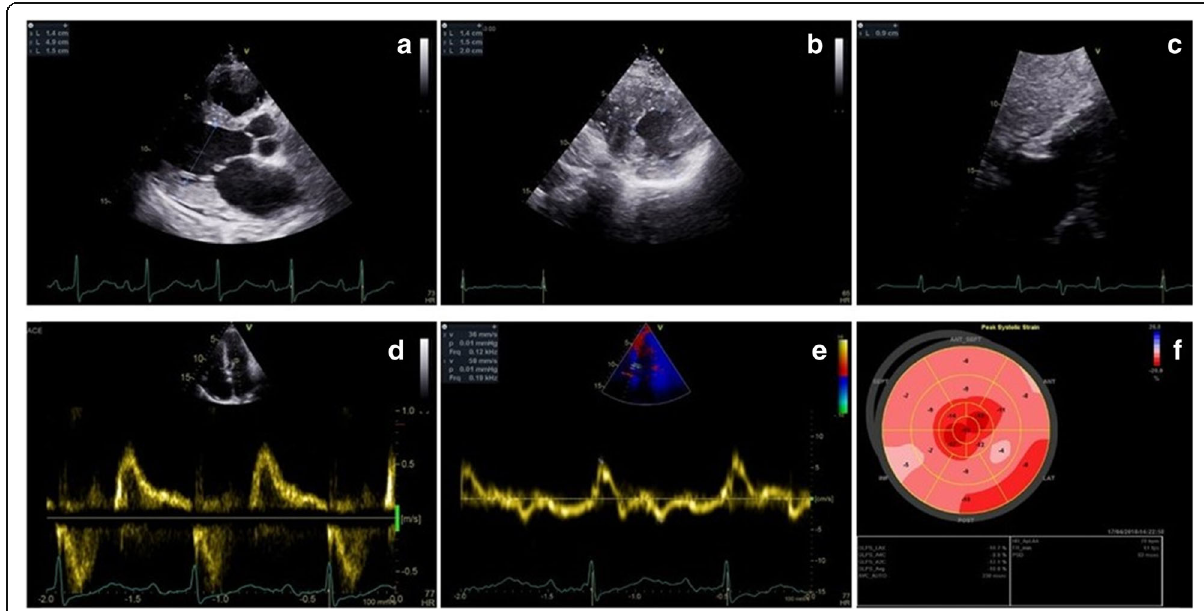
Fig. 2 Transthoracic 2D echocardiography. a. Parasternal long-axis section revealing concentric LV hypertrophy. b. Parasternal midventricular short axis with maximal wall thickness of 20 mm at inferoseptal level. c. Subcostal view with RV free wall hypertrophy (9 mm). d. Transmitral flow Doppler interrogation finds grade 3 diastolic dysfunction. e. Myocardial Doppler interrogation of the septal mitral annulus shows low longitudinal systolic and diastolic velocities. f. Bull ’ s eye LV myocardial deformation map with low global longitudinal strain and apical sparring